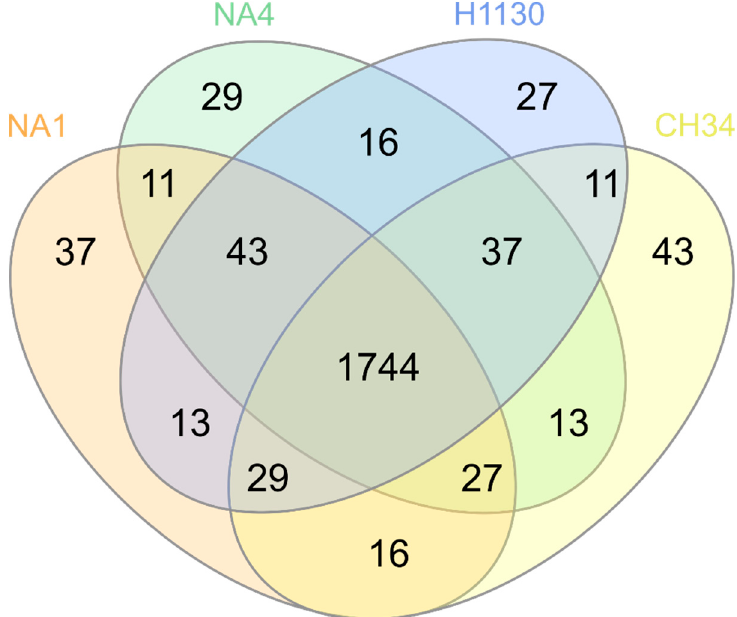
Figure 9. Venn diagram displaying the distribution of OmniLog phenotypic assays shared among C. metallidurans CH34, NA1, NA4 and H1130.